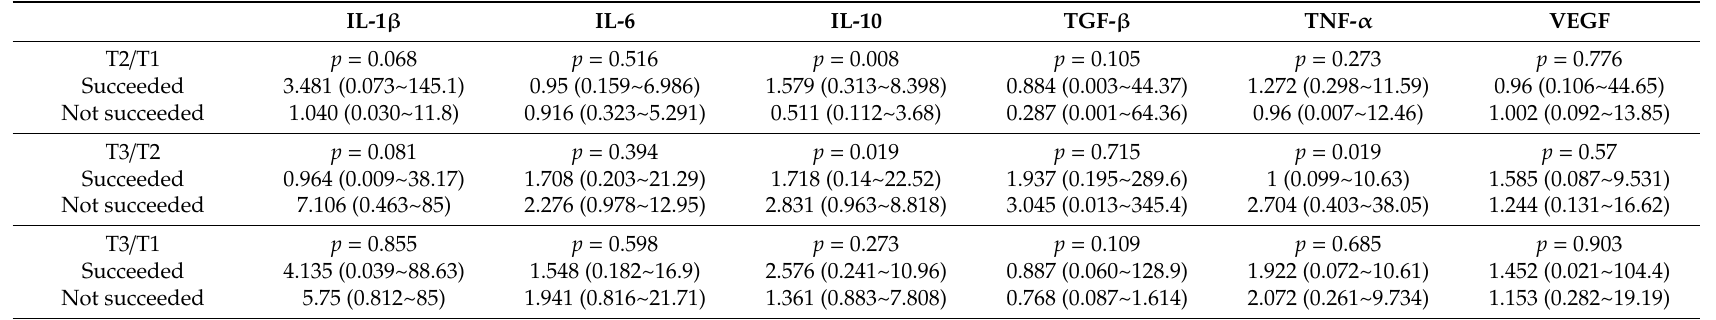
Table 3. Fold changes of pleural fluid cytokines and VEGF levels between di ff erent time points were compared between patients who succeeded pleurodesis ( n = 19) and those not succeeded ( n = 12)